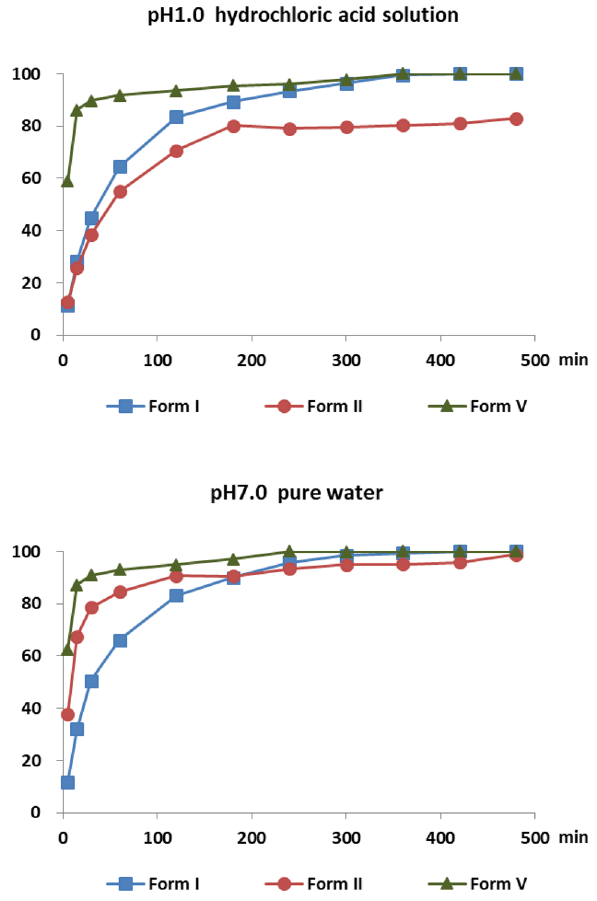
Fig. 13 Solubility studies on mangiferin form I, form II and form